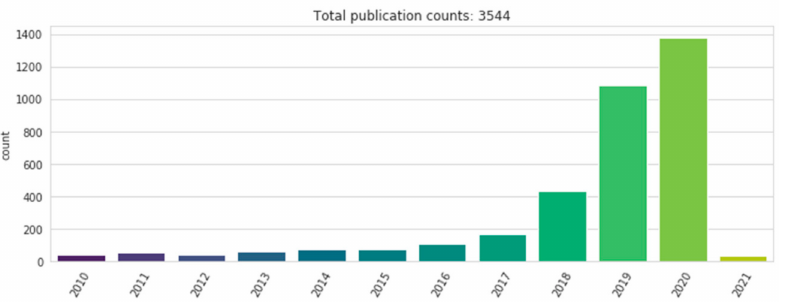
Figure 1. The number of research publications on ML explanations (based on Scopus.com